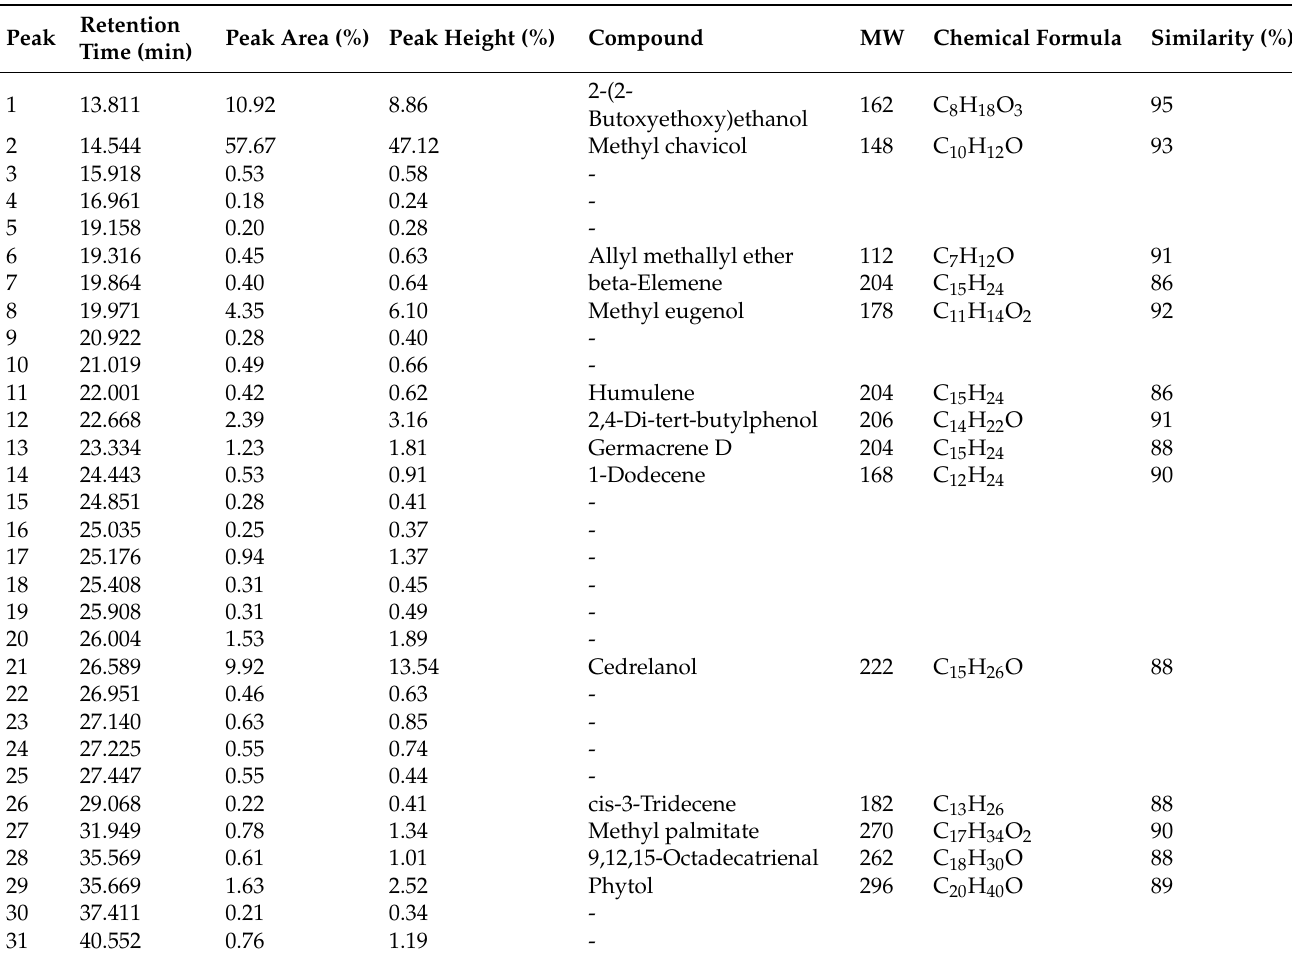
Table 2. Phytochemical profiling of the subfraction H-F345-S2 derived from the hexane extract of the leaves of O. basilicum using gas chromatography–mass